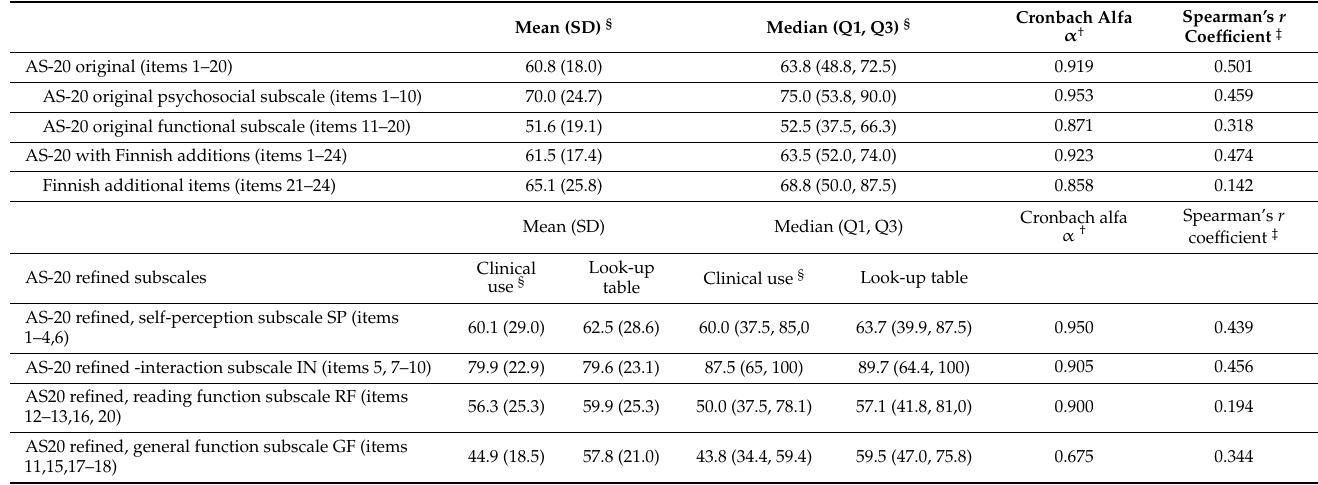
Table 3. Descriptive statistics and psychometric properties of the three Finnish AS-20 structures and their subscales ( n =